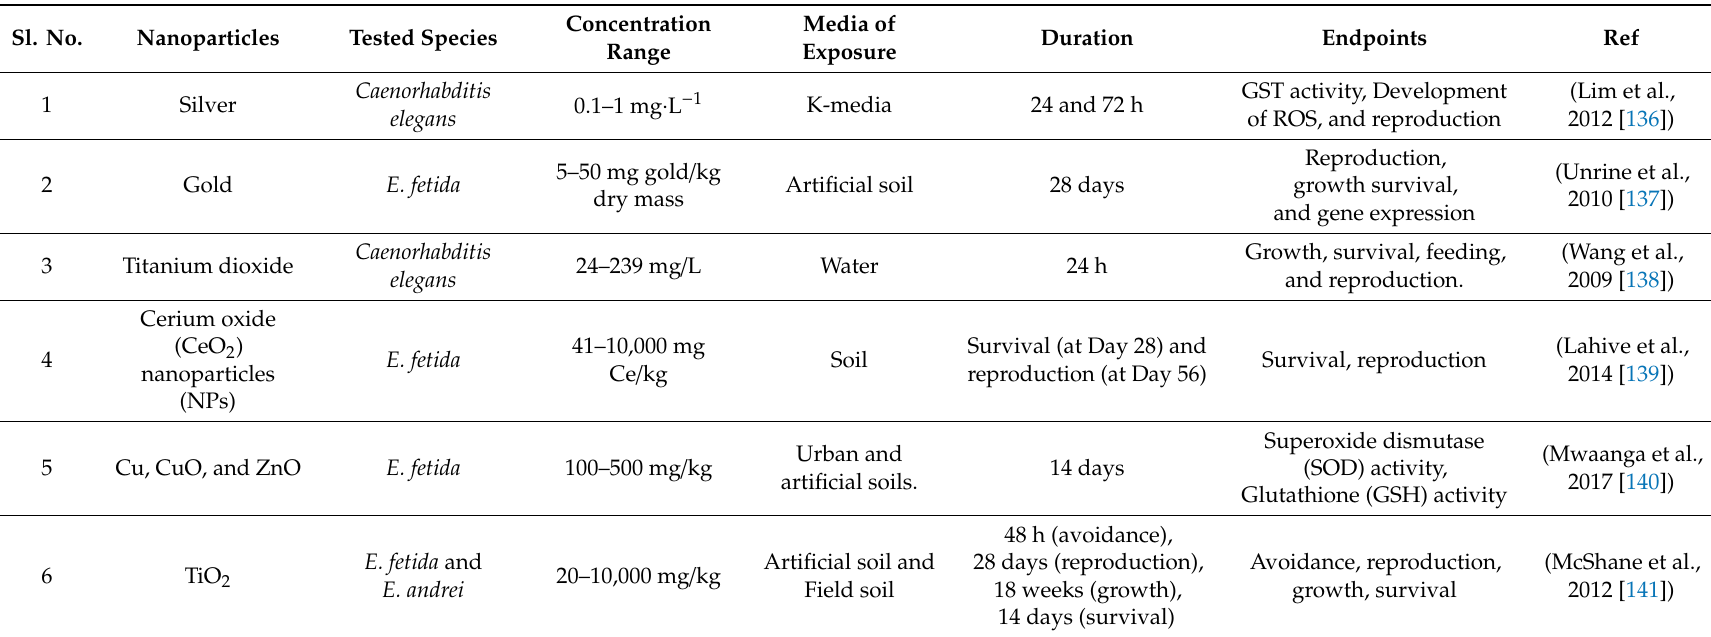
Table 3. Toxicity to the soil invertebrates caused by metal